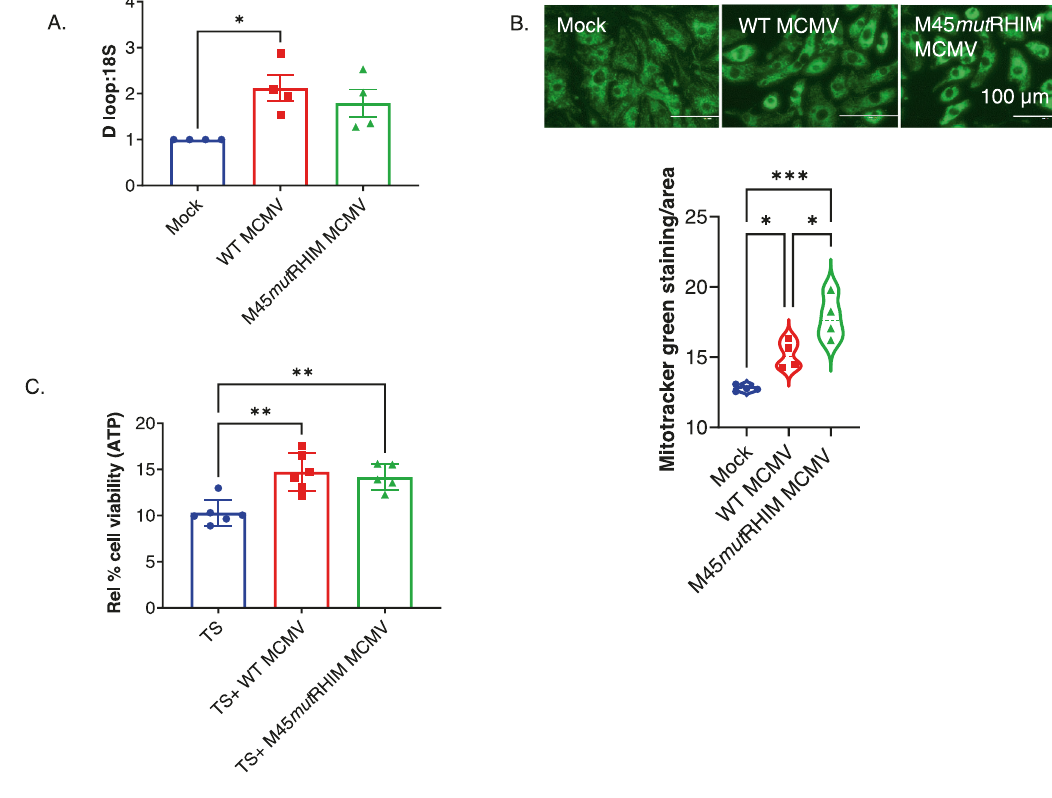
Fig. 3 MCMV infection increases mitochondrial biogenesis to promote cell viability in primary cardiomyocytes. A Mitochondrial DNA copy number assessed by D-loop in uninfected (MOCK), WT MCMV, and M45mutRHIM MCMV infected neonatal cardiomyocytes. B Morphology and cell viability of uninfected and WT and M45mutRHIM MCMV infected neonatal primary cardiomyocytes. C Effect of apoptosis inducer TS on viability of uninfected, WT MCMV, and M45mutRHIM MCMV infected neonatal cardiomyocytes. WT CMV = K-181- bac. One-way ANOVA followed by Tukey ’ s multiple comparison test was performed. Values are mean ± SE. Each point represents one sample. n = 4 – 6 in each group. * P < 0.05; ** P < 0.01; *** P <